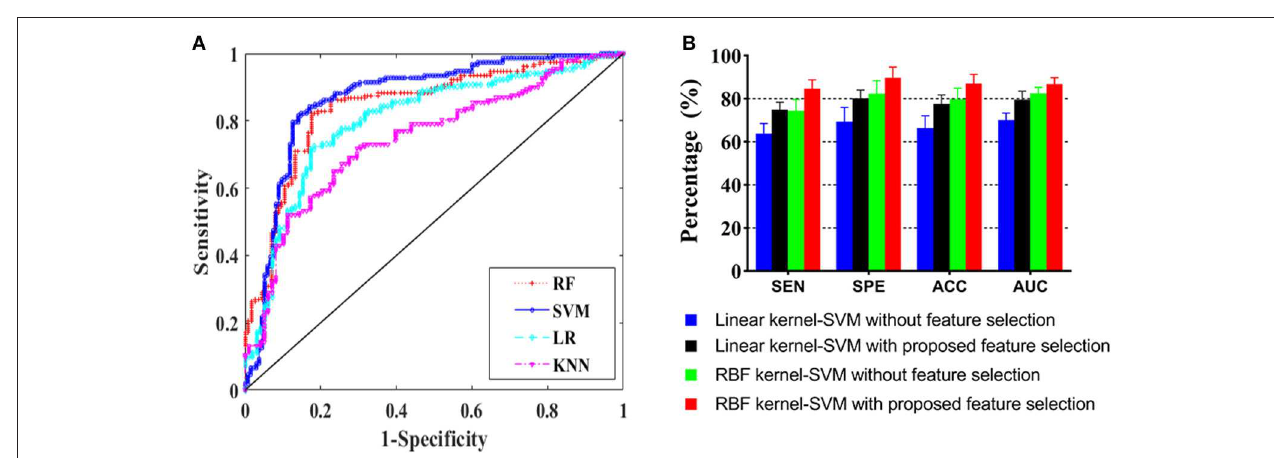
FIGURE 4 | Model performance presentation. (A) ROC curves for different machine learning models and (B) performance comparison for SVM with linear and radial base function (RBF) kernels on the raw and optimized